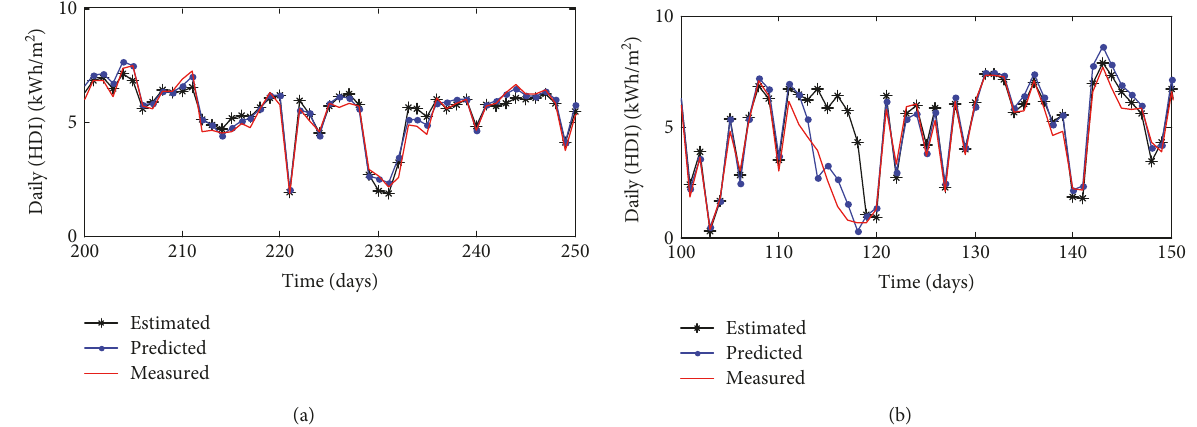
Figure 12: Comparison between estimated, predicted, and measured daily direct solar radiation.